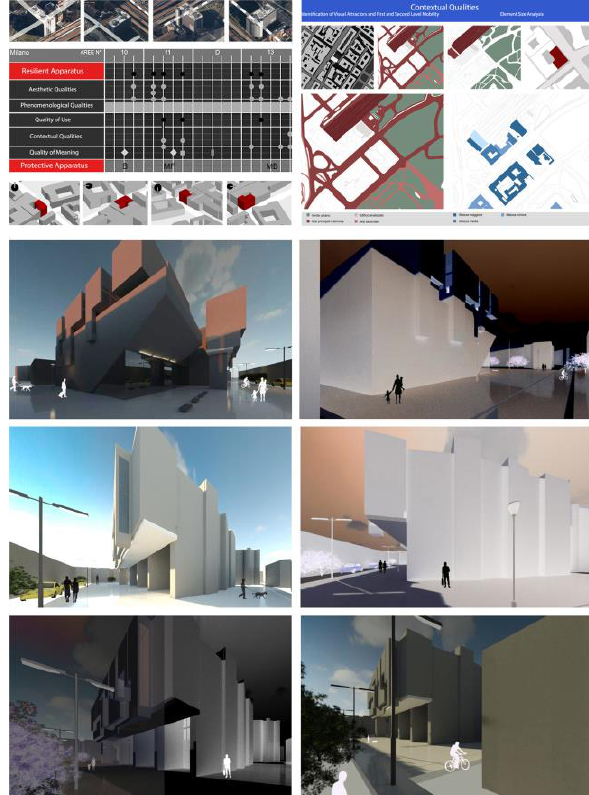
Figure 11. New Bocconi University headquarters in Milan - Grafton building in via Röntgen (2008). Resilience area: Resilient models with the elements of visual shooting Brera Academy of Fine Arts Milan (A. De Masi).